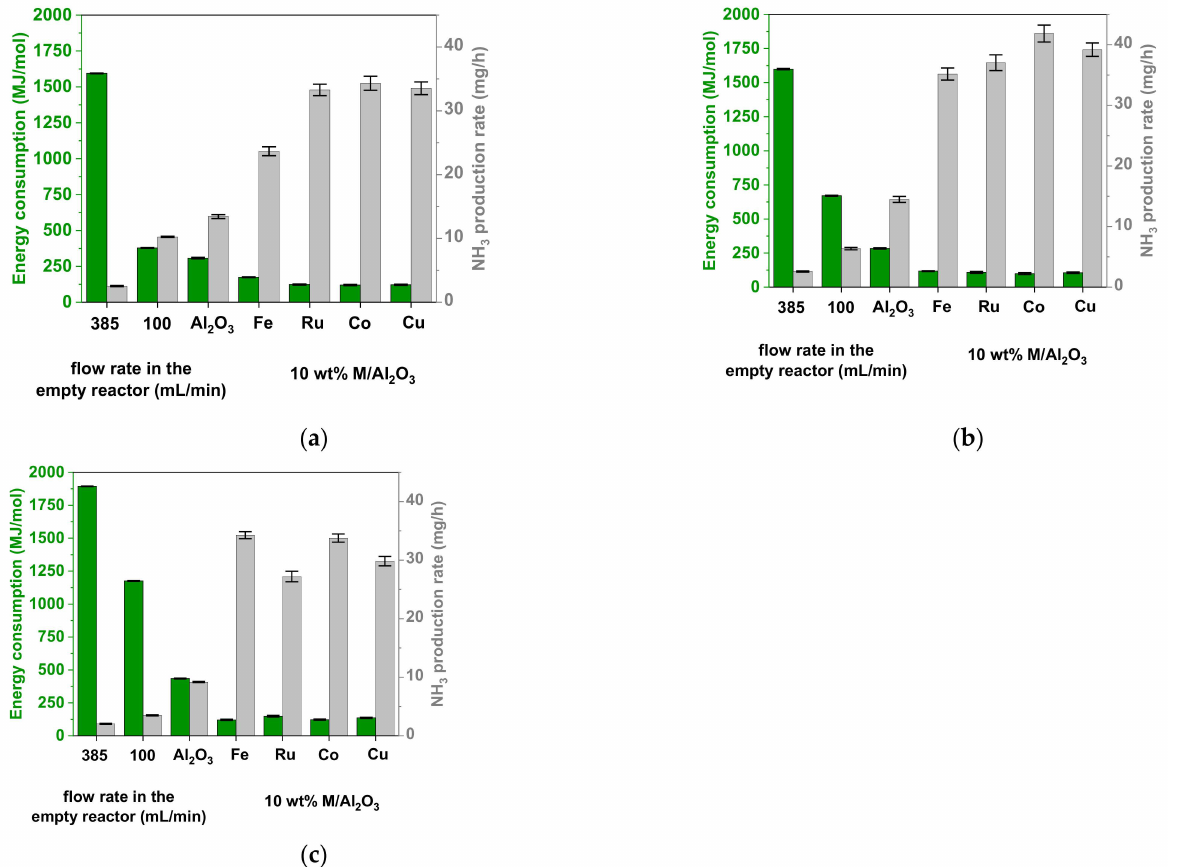
Figure 6. Energy consumption of NH 3 formation (left y-axis) and NH 3 production rate (right y-axis), obtained from N 2 and H 2 in the plasma-catalytic reaction within the DBD reactor, for an empty reactor and a packed reactor with pristine Al 2 O 3 beads, and Al 2 O 3 beads impregnated with 10 wt% Fe, Ru, Co, or Cu catalyst. The empty reactor was used with two different feed gas flow rates: 385 and 100 mL/min, to have the same residence time and same mass flow rate, respectively, as the packed reactor. The experiments were performed with three H 2 :N 2 ratios: ( a ) 3:1; ( b ) 1:1; ( c ) 1:3. The error bars denote the standard deviation between three independent